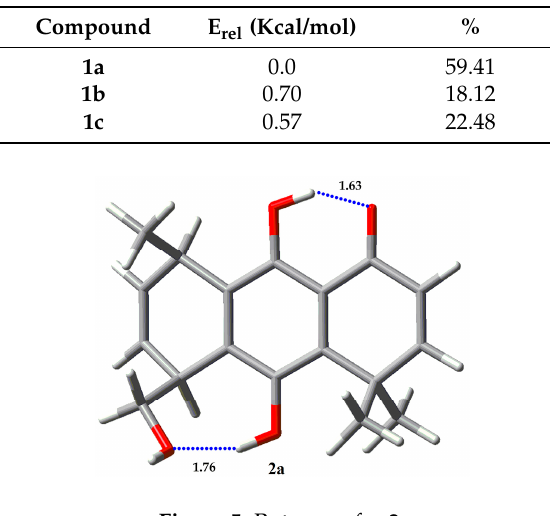
Figure 5. Rotamers for 2 . Table 2. Boltzmann population for rotamers of 2